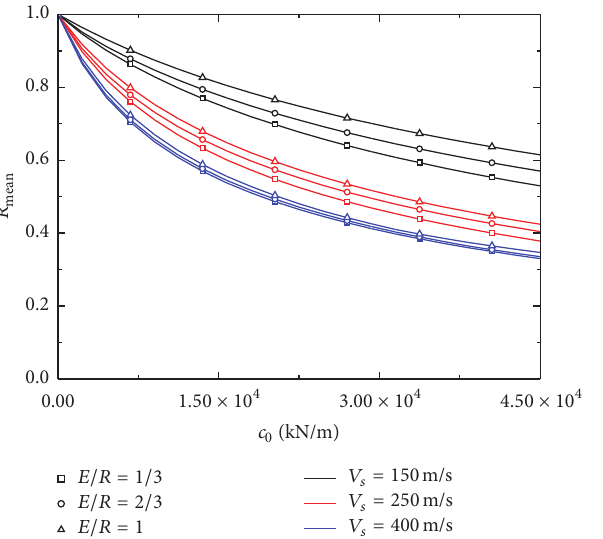
Figure 9: The mean reduction ratio for structures with various degrees of foundation embedment ratio (10-story structures).